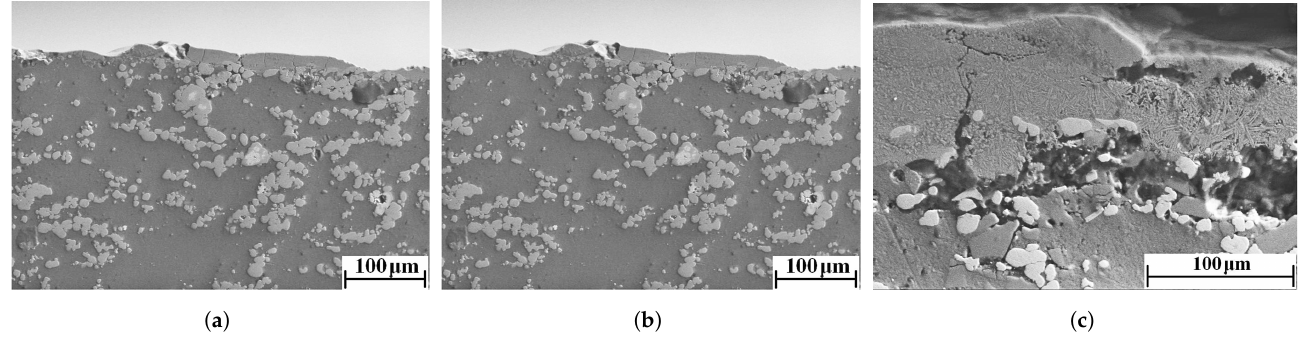
Figure 4. SEM image of the cross section of the cathodes’ modified layer: ( a ) Al 0.7 Cr 0.3 ; ( b ) Al 0.65 Cr 0.25 Si 0.1 ; ( c ) Al 0.6 Cr 0.2 Si 0.2 .